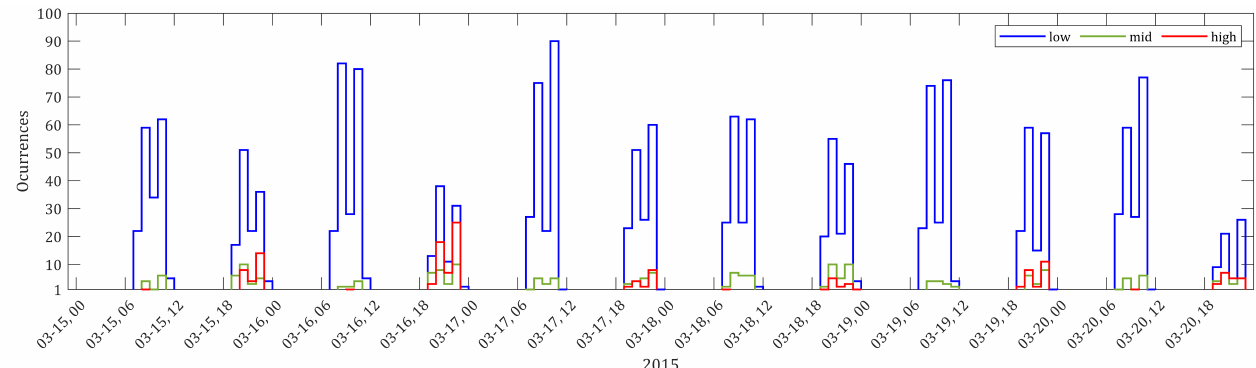
Figure 6. Local time distribution of S 4 index on MetOp-A,B occultations during the first period with high solar activity, i.e., 15 March (DOY 74) to 20 March (DOY 79) in 2015. “Low” corresponds to S 4 ≤ 0.2, “Mid” to 0.2 < S 4 ≤ 0.5 and “High” to S 4 > 0.5. Strong scintillations were observed mostly during evenings.